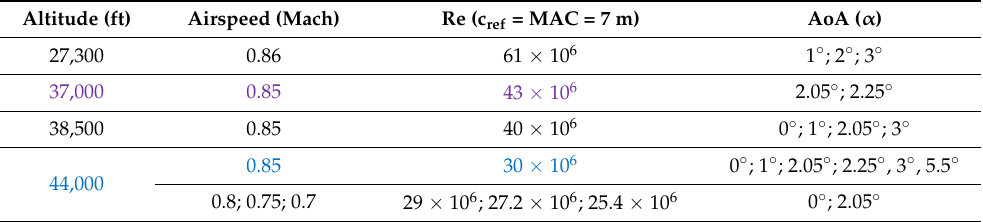
Table 2. CRM aircraft: Flight conditions (S 1 and S 2 highlighted in blue and purple, respectively). Altitude